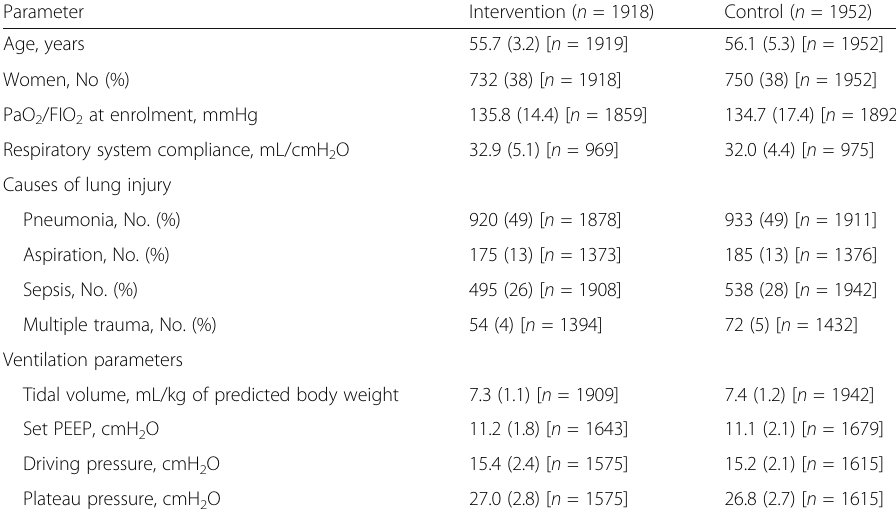
Table 2 Baseline characteristics of patients included in the meta-analysis